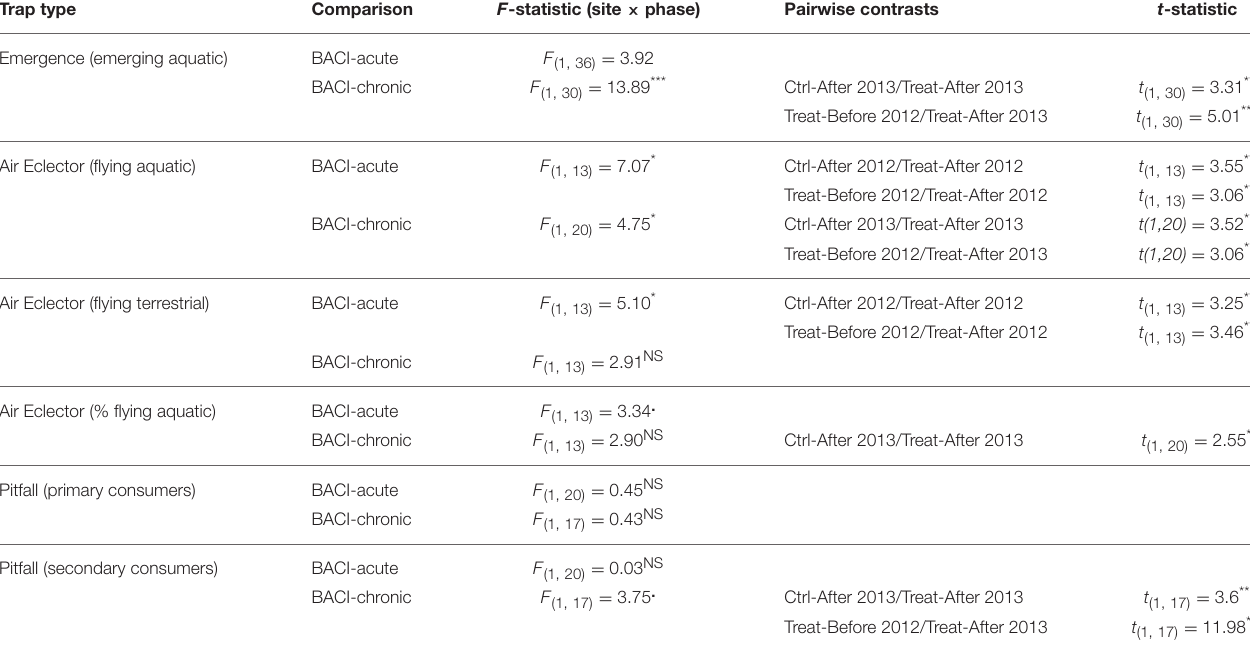
TABLE 1 | Arthropod abundance (CPUE) analysed using a BACI design. Trap